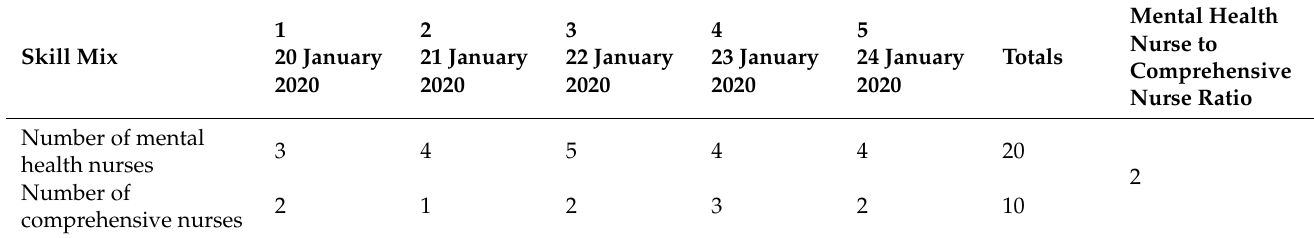
Table 1. The daily skill mix exposure for patient X for each day of their